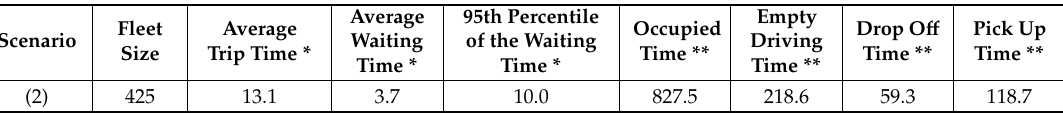
Table 3. Trip time components of travelers in scenario (2), when the AV fleet was used.